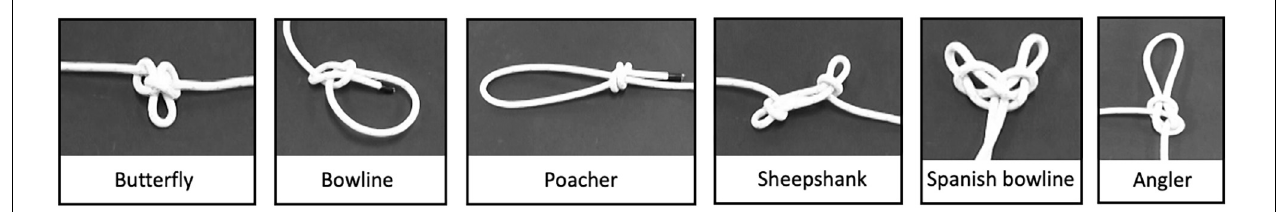
FIGURE 1 | Experimental stimuli. Final configuration of the six nautical